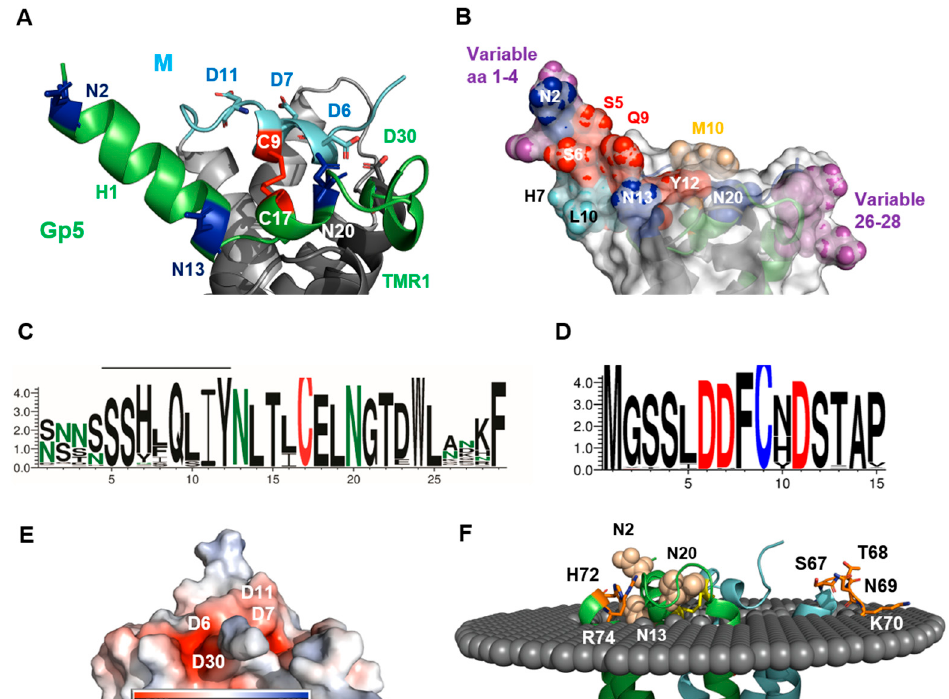
Figure 3. The structure of the ectodomain of Gp5/M of PRRSV-2. ( A ) Cartoon model. Hydrophilic residues in Gp5 are colored green and in M are colored cyan. Hydrophobic membrane parts of Gp5 are colored dark grey and of M are colored light grey. N-glycosylated Asn are shown as blue sticks, residues forming the disulfide bond between Gp5 and M are shown as red sticks and Asp residues in Gp5 and M are shown as green and cyan sticks, respectively. ( B ) Surface representation of the ectodomain . N-glycosylation sites are shown as blue spheres, and between PRRSV-2 strains, varia- ble amino acids are shown as magenta spheres. The neutralizing epitope (residues 5–12) is also highlighted, conserved residues are highlighted as red spheres and the between strains variable residues are highlighted as cyan spheres. Residue 10 of M, which is also involved in antibody bind- ing, is shown as a wheat sphere. ( C , D ) Web logo showing the amino acids at each position in the ectodomain of Gp5 ( C ) and M ( D ). Logos were generated from 7701 aligned Gp5 and 290 aligned M amino acid sequences from PRRSV-2 strains. The overall height of the stack indicates the sequence conservation at a position (x-axis), while the height of symbols within the stack indicates the relative frequency of each amino. Asn residues are labeled green, Cys is labeled red ( C ) or blue ( D ) and Asp residues are labeled ( D ) in red. The neutralizing epitope in Gp5 is highlighted by a black line. ( E ) Electrostatic surface potential of the Gp5/M ectodomain. The location of negatively charged Asp residues is indicated. The structure is rotated clockwise by 90° relative to the structure shown in A. The scale bar indicates the electrostatic surface potential from − 5 (deep red) to +5 (deep blue). ( F ) Integration of Gp5/M into a virtual lipid bilayer. The border between the hydrophobic and hydro- philic part of the external part of the bilayer is shown as grey spheres. Gp5 and M are shown as green and cyan cartoons, respectively. The N-glycosylation sites are shown as wheat spheres, and amino acids located in the loop between transmembrane helices 2 and 3 of both Gp5 and M and protruding from the membrane are shown as orange sticks.